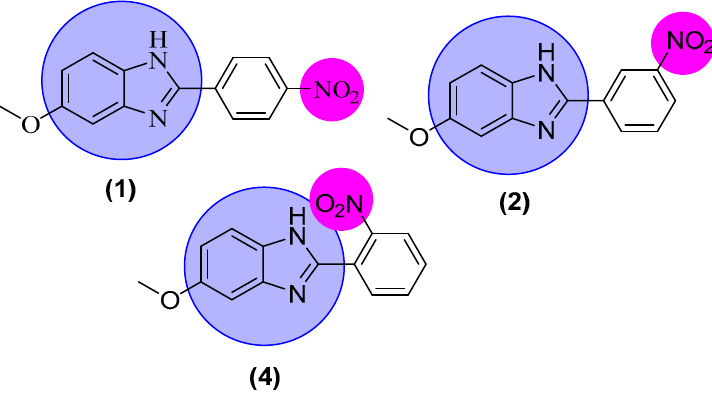
Figure 9. SAR studies of compounds 1 , 2, and 4 .